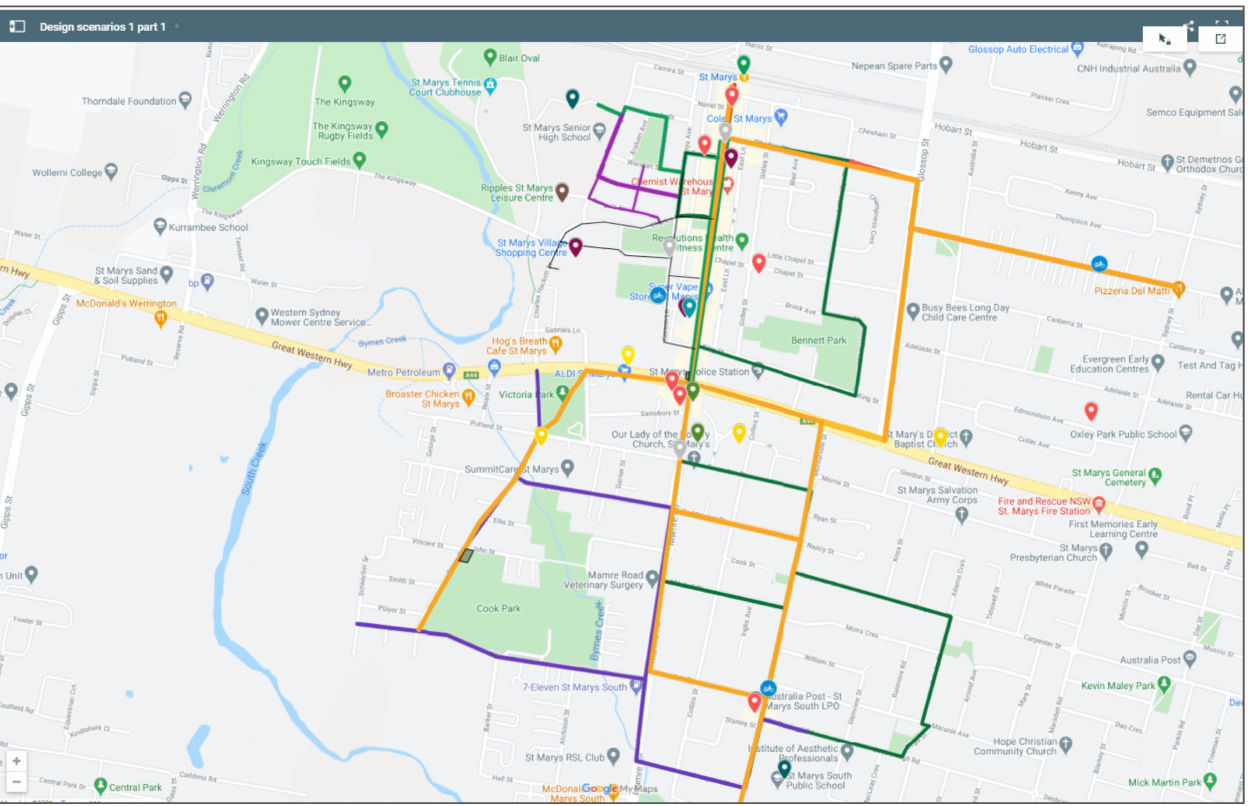
Figure 7. Screenshots of sketch designs using Google My